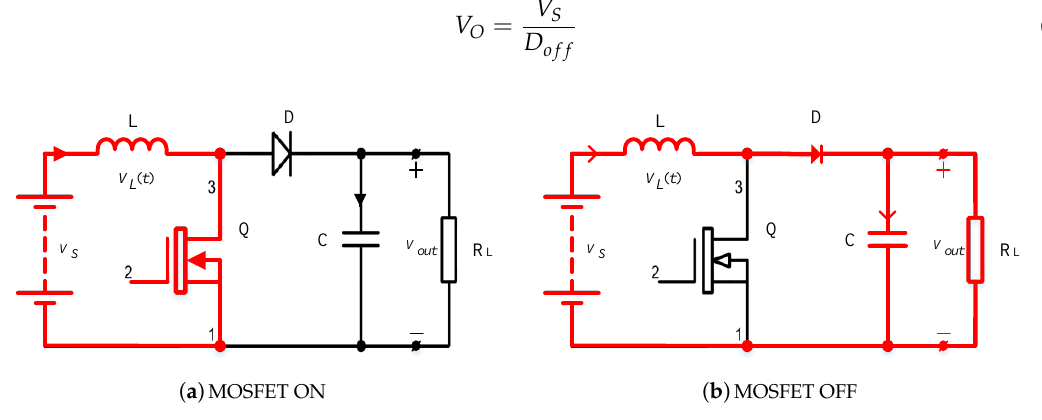
Figure 4. The MOSFET states of the boost converter.